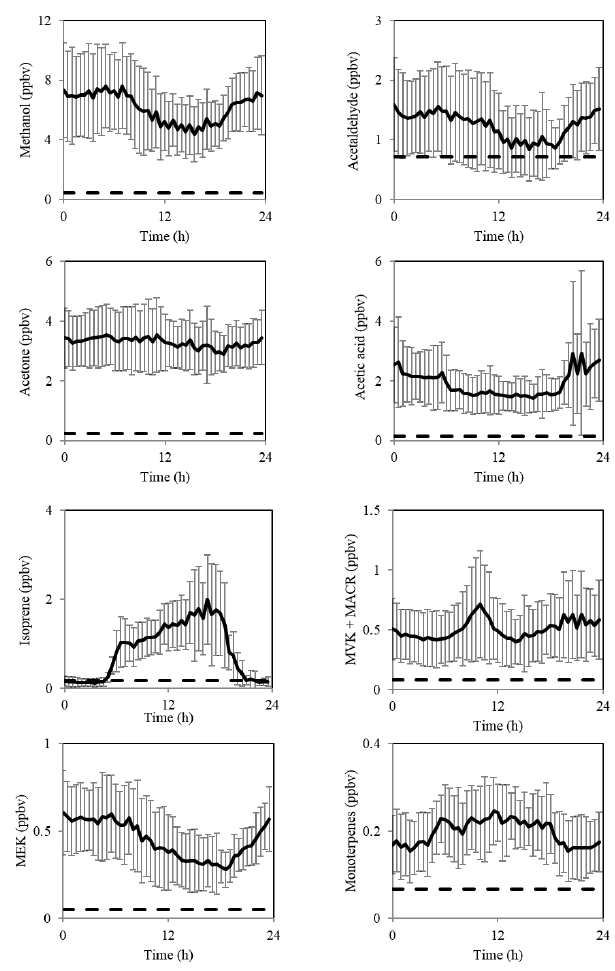
Figure 3. Mean 4m above-canopy diurnal mixing ratios by volume of volatile organic compounds measured during the Bosco Fontana field campaign. Error bars represent one standard deviation from the mean and the dashed line denotes limit of